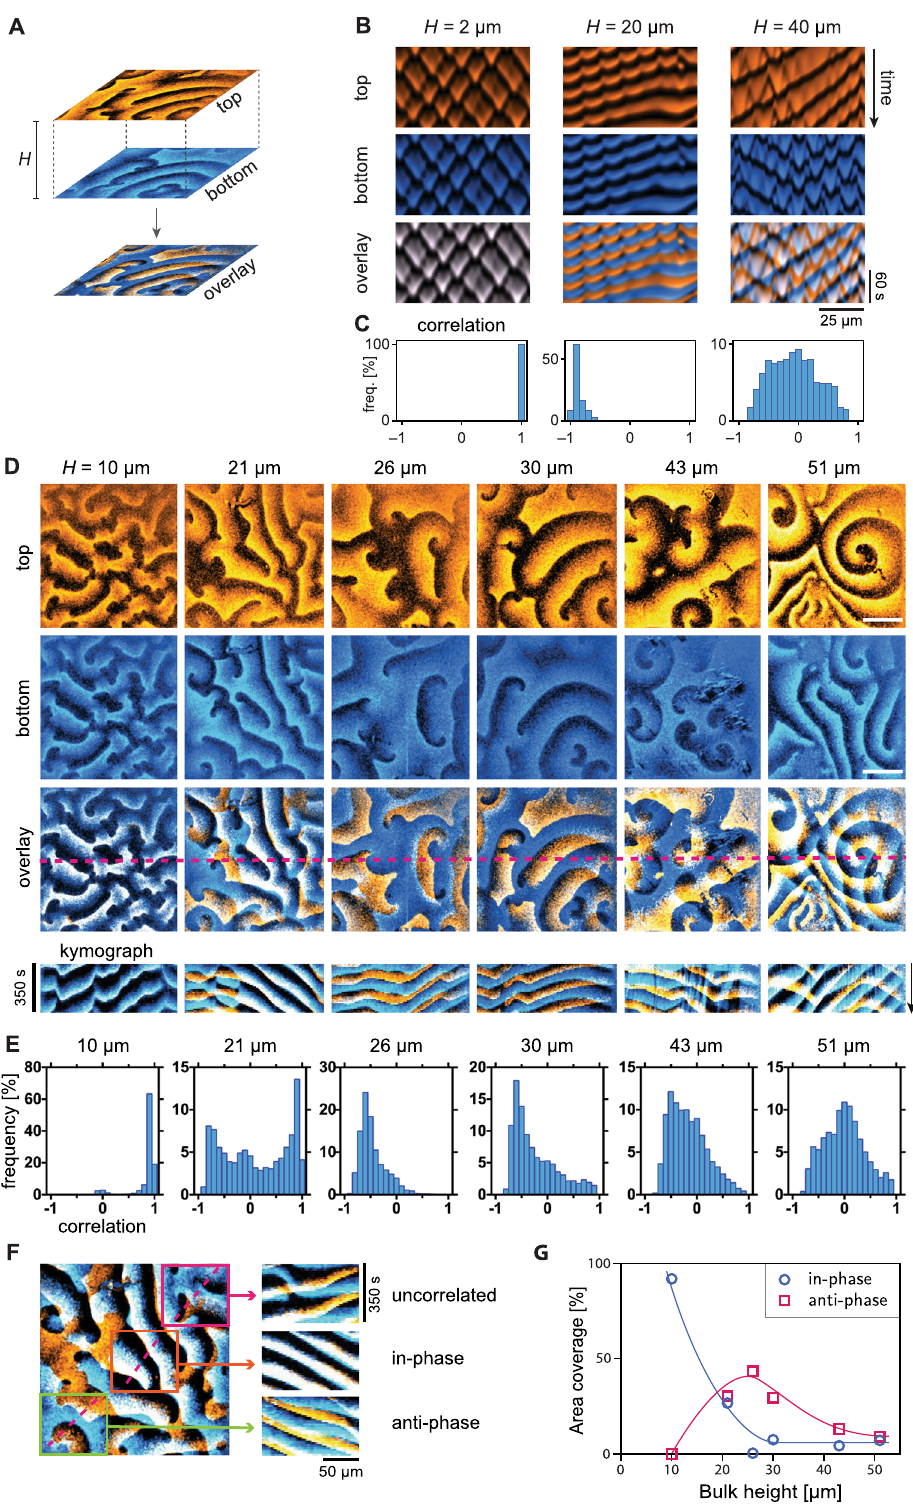
Supplementary Movie 15 showing an example of threefold multi- stability). By contrast, for low bulk height (2 μ m) we found only a single instance of (twofold) multistability ( H = 2 μ m, E : D = 2), whereas for large bulk height (57 μ m) we did not observe any multistability at all. In agreement to these experimental fi ndings, numerical simulations for small and large bulk heights do not show multistability of qualitatively different patterns. Note that for E : D > 1,